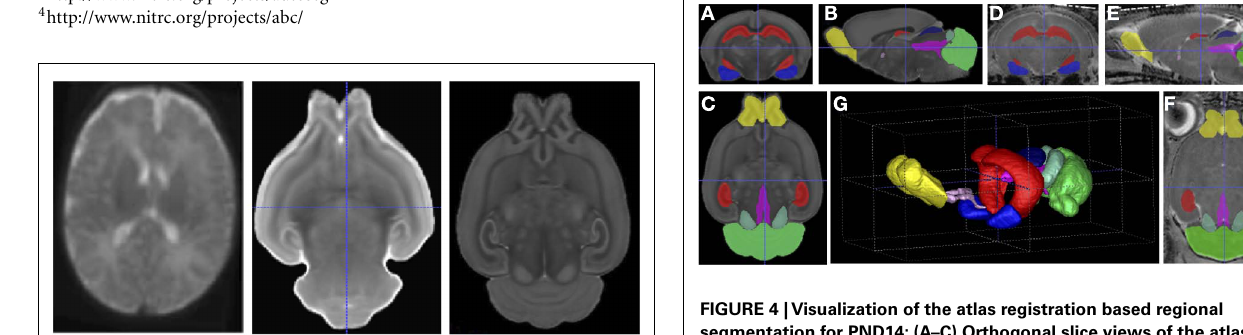
FIGURE 3 | Human neonateT2-weighted atlas (left) and rodent MD atlas at PND 5 (middle) and PND 14 (right).